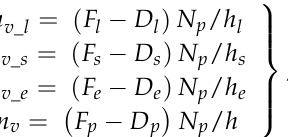
Figure 2. The rice morphologies at different phenological stages are shown along with the SAR image acquisition dates. The phenological stages are quantified using the BBCH scale.